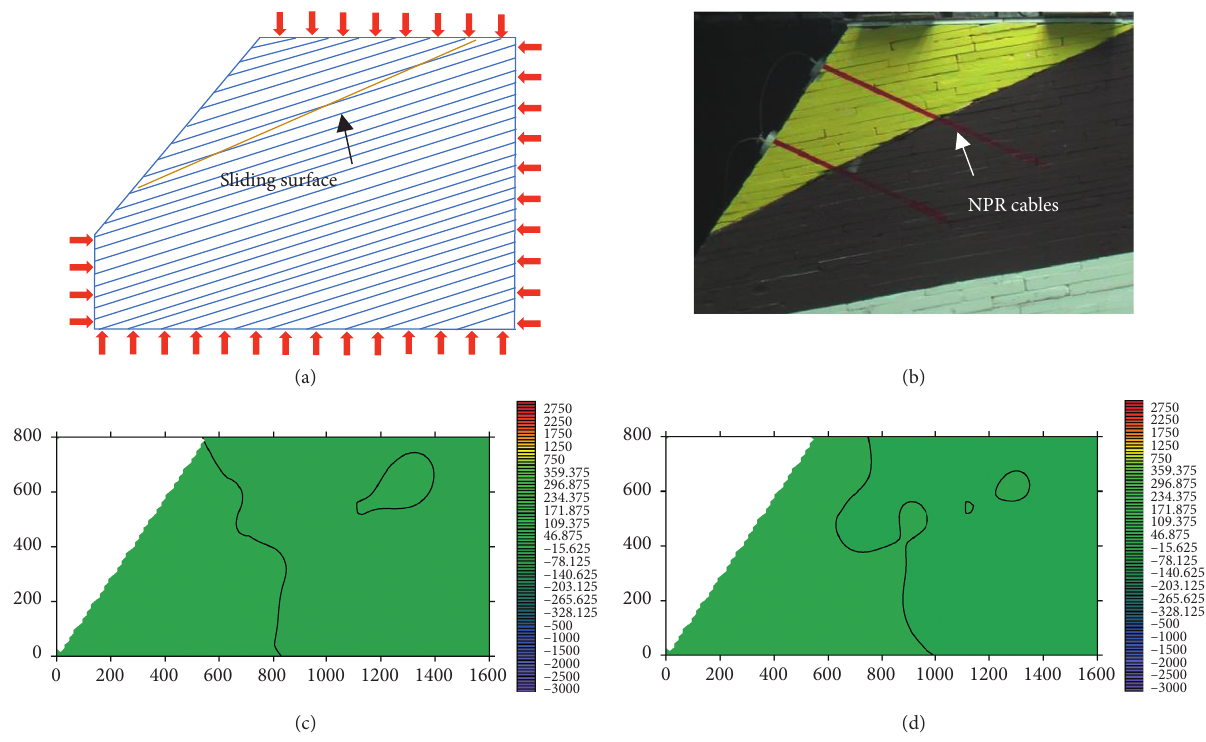
Figure 13: Pre-load strain cloud data. (a) Model loading diagram. (b) Model loading variation diagram. (c) X-directional strain cloud map. (d) Y-directional strain cloud